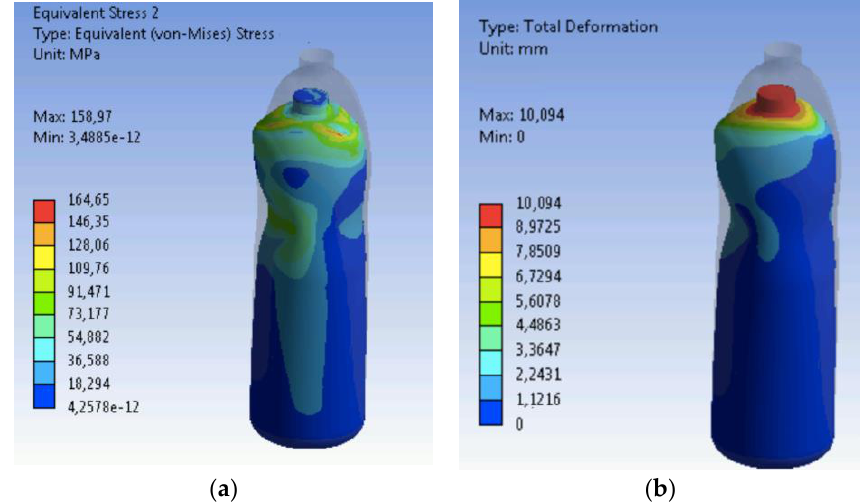
Figure 10. Quasi-static analysis in top-load conditions for a 10 mm vertical displacement: diagram of stress ( a ) and strain ( b ).